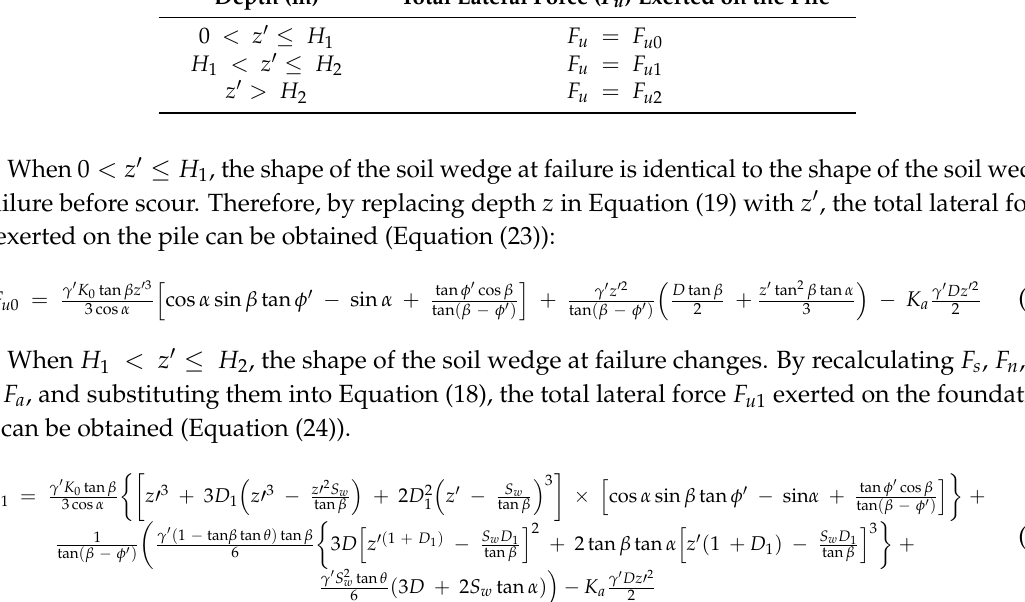
Table 1. Total lateral force exerted on the foundation pile at a depth of z ’. Depth (m) Total Lateral Force ( F u ) Exerted on the